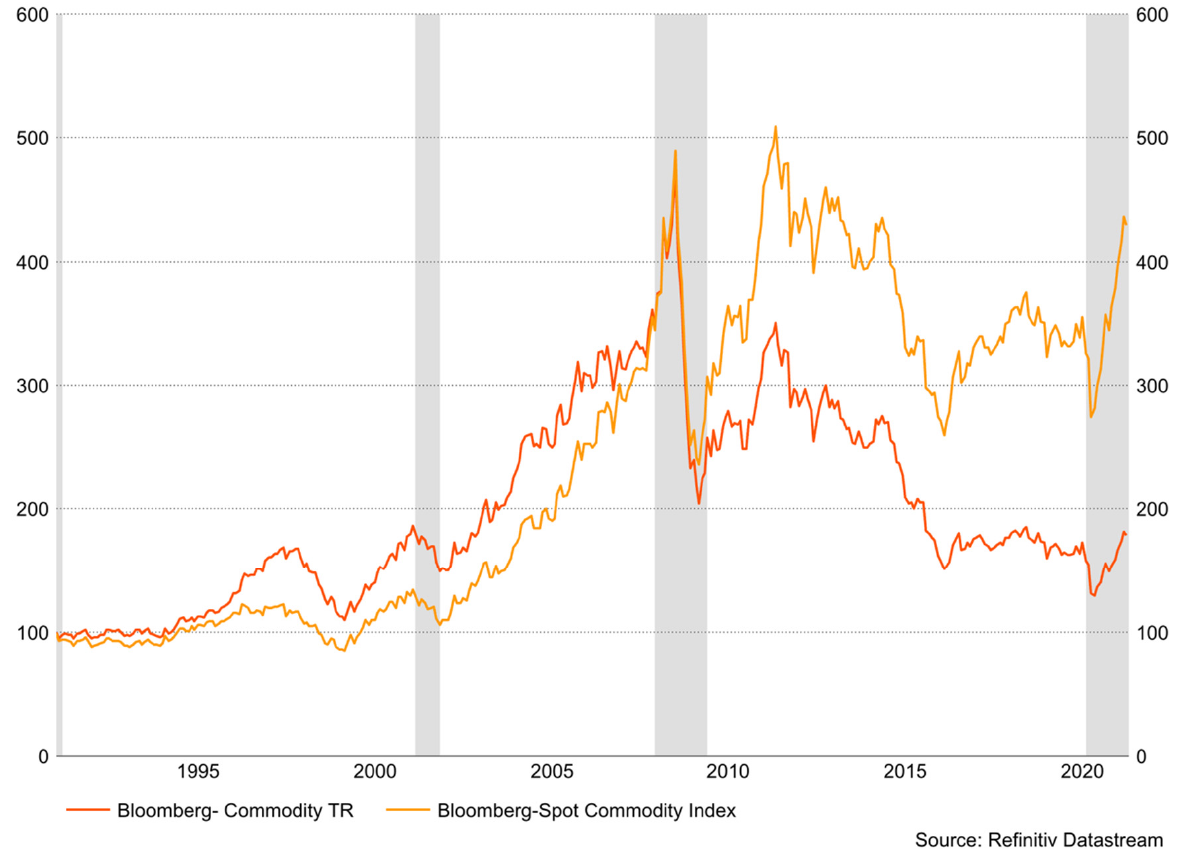
Figure 3. Bloomberg Commodity Index.